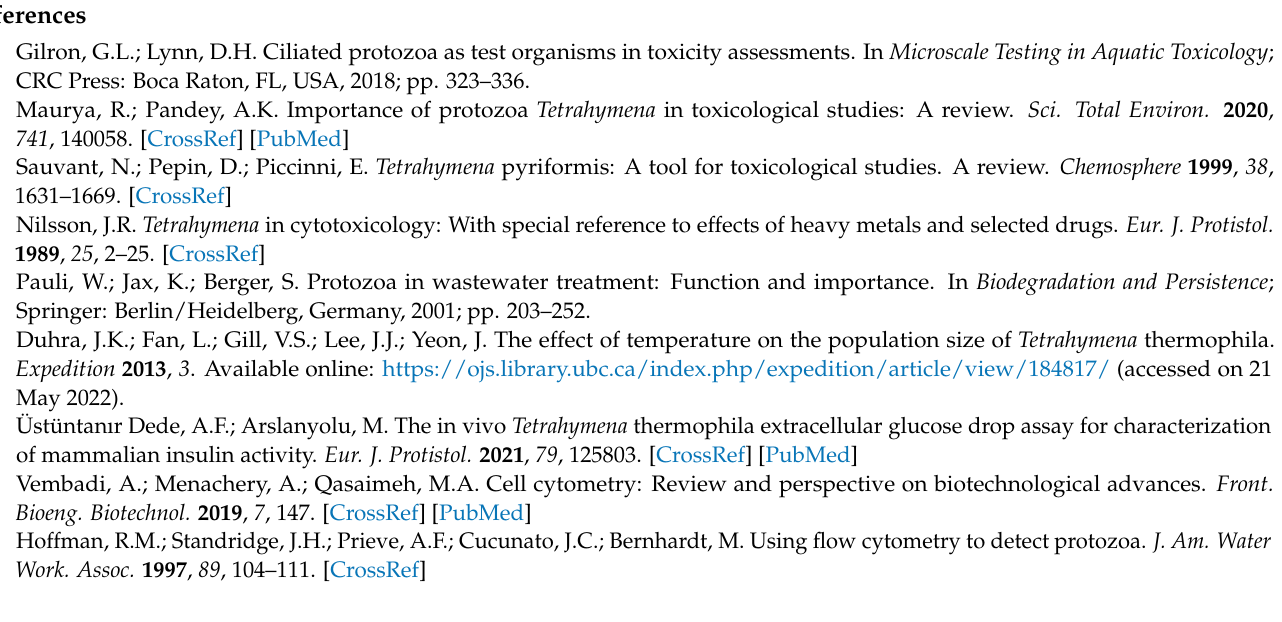
Figure A1. Tetrahymena images at either ( A ) middle-log phase or ( B ) late-log phase. In the late-log phase, cells become smaller than their counterparts in the middle-log phase. Both densities are used to calculate the relation between manual counting method which is the most common method to count Tetrahymena cells to 5 methods we